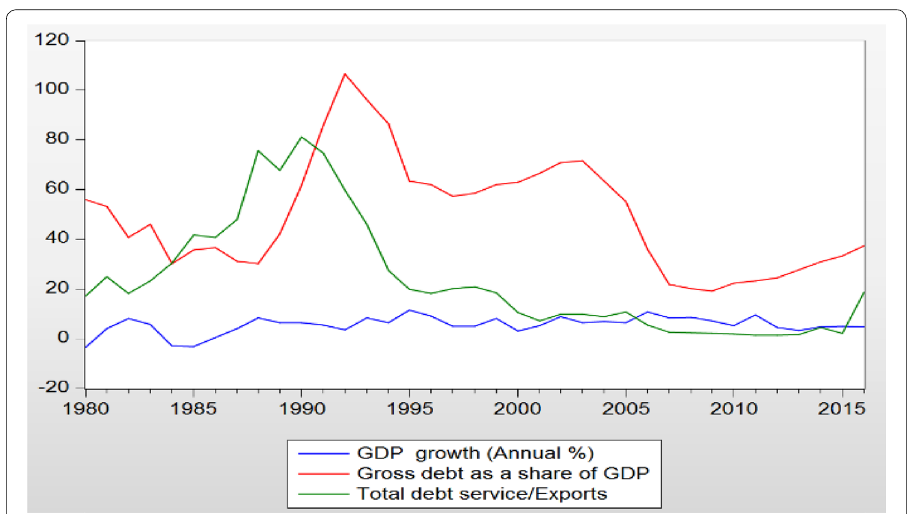
Fig. 1 Uganda’s public debt in relation to debt to GDP, debt service to exports and GDP growth rate (Source: World Bank,